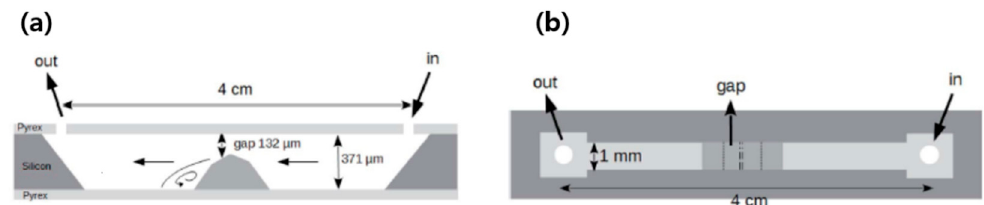
Figure 12. Schematic of a “lab–on–a–chip” (LOC) device: ( a ) profile view and ( b ) top view. Reprinted with permission from reference [19], copyright 2019, Royal Society of